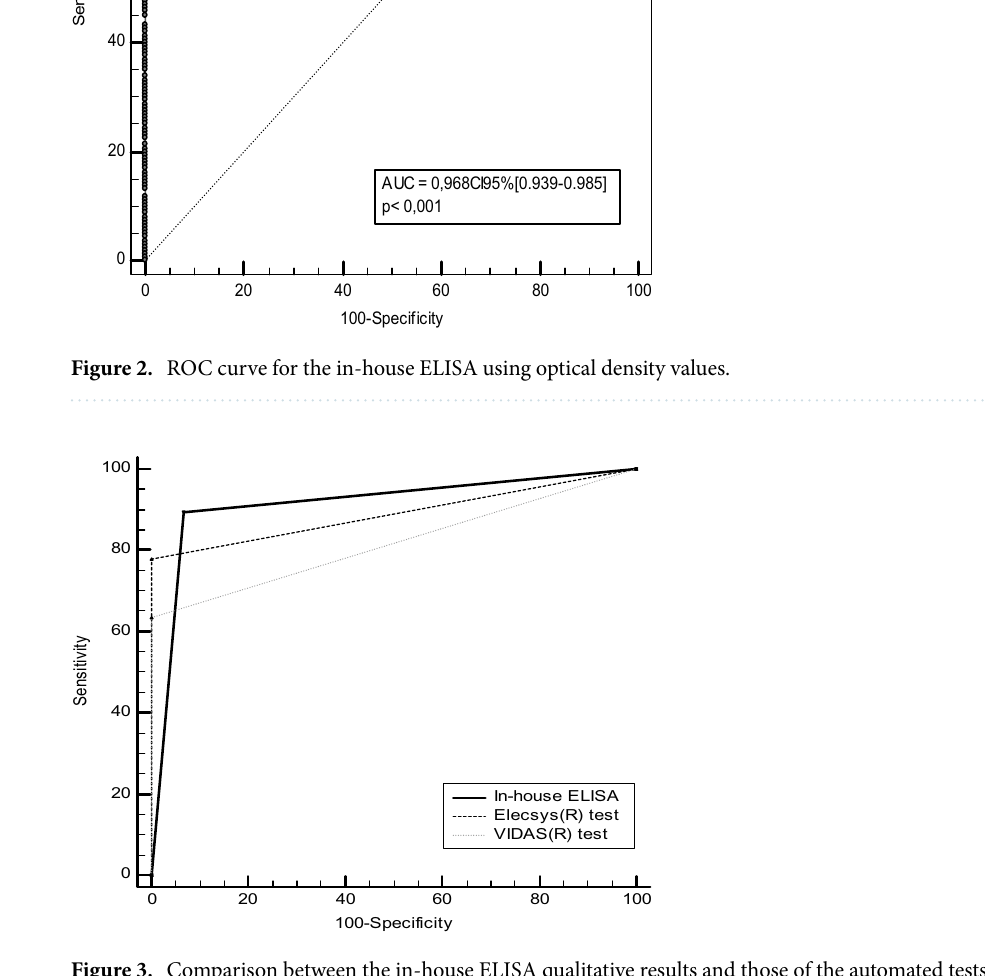
Figure 3. Comparison between the in-house ELISA qualitative results and those of the automated tests Vidas SARS-CoV-2 IgG anti-RBD Biomérieux and Elecsys Anti-Nucleocapsid of SARS-CoV-2